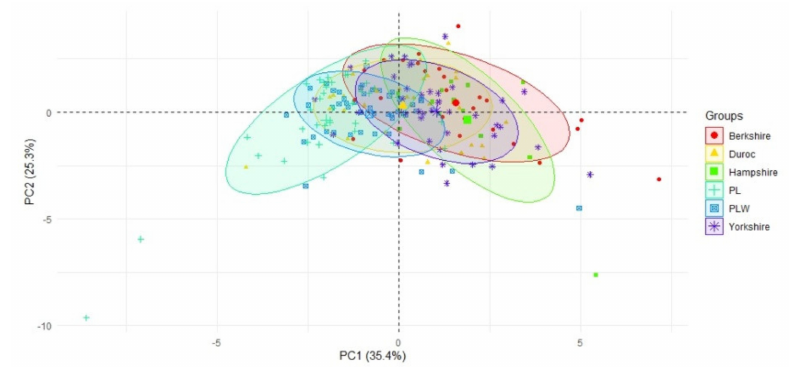
Figure 1. A scatterplot of the first principal component (PC) against the second PC, with the indication of the breeds. The first PC was correlated with the number and percentage of piglets born alive per litter and with the number of weaned piglets per litter (negative correlation), and the percentage of stillborn piglets per litter (positive correlation), while the second PC was correlated with the farrowing and farrowing-to-conception intervals (negative correlation). Axes represent loadings onto components 1 and 2.